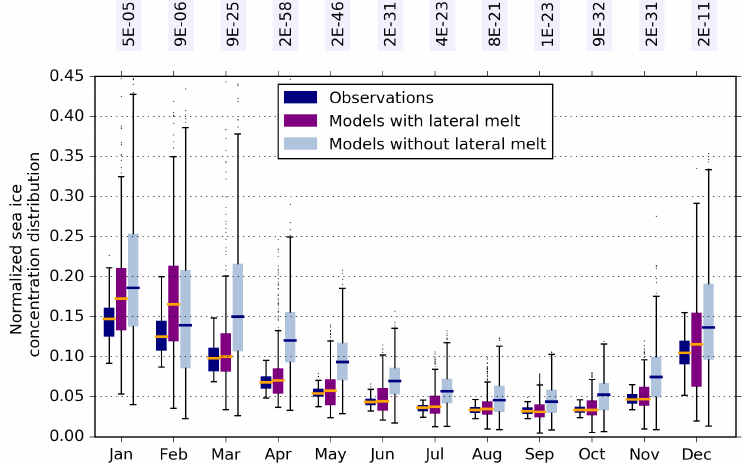
Figure 7. The 10–20% bin from the normalized sea ice concentration distribution for each month, where boxes contain all years from 1992 to 2014 from (blue) the three sets of satellite observations, (purple) CMIP5 models that include an explicit lateral melt term, and (grey) CMIP5 models that do not (from Table 1). Box plots as in Fig. 1. Annotated text is the p value calculated from a Kolmogorov–Smirnov test, which represents the confidence that the two populations come from the same